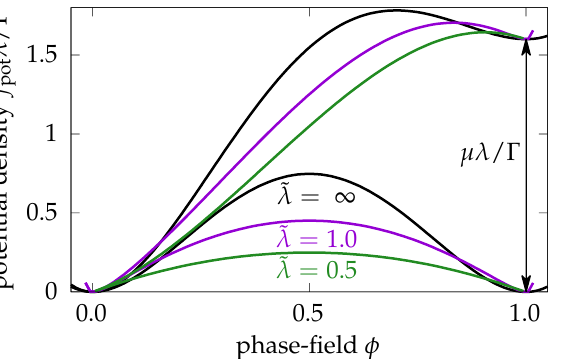
Figure 4. Joint potential energy density, f pot ( φ ) λ / Γ = g k ( φ ) / C Γ + µ h 3 ( φ ) λ / Γ , as a function of the phase-field φ with the vanishing (approximately parabolic curves) and non-vanishing (approximately sigmoid shaped curves) driving force, for different values of the dimensionless interface width ˜ λ = λ / ∆ x . The equilibrium potential g ( φ ) is given by Equation (6), and h ( φ ) = φ 2 ( 3 − 2 φ ) 3 k